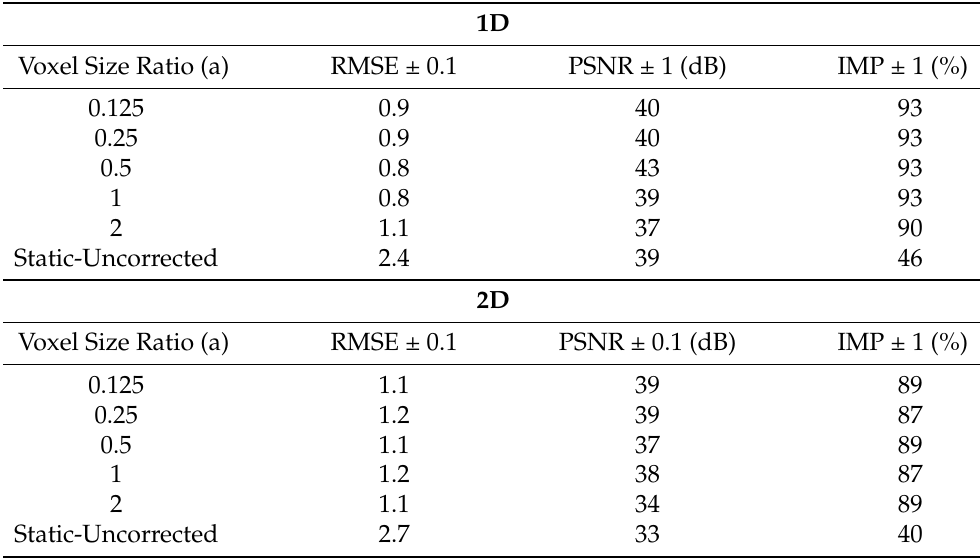
Table 6. RMSE, IMP, and PSNR values for a sinusoidal motion in one and two dimensions for different voxel size